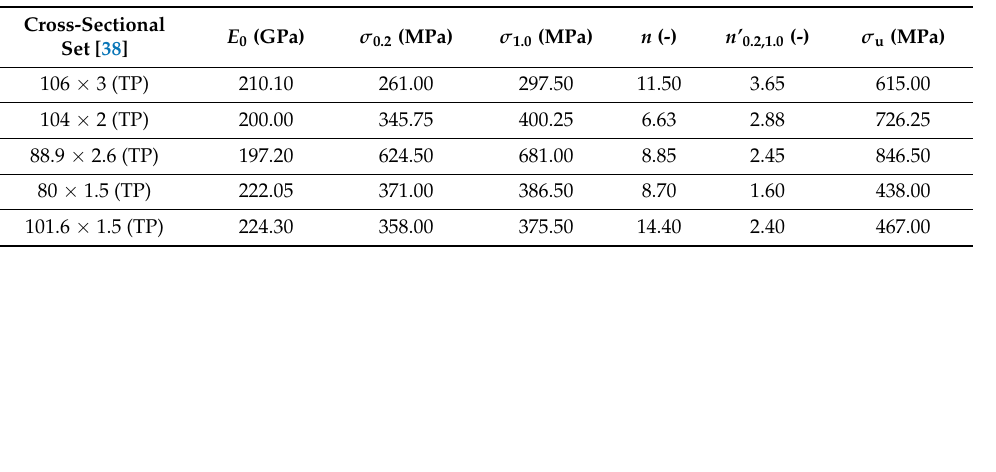
Table 2. Summary of the tensile coupon material properties